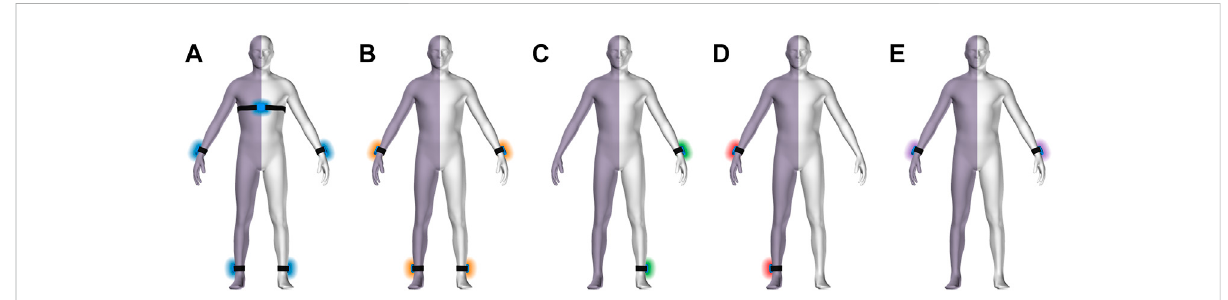
FIGURE 1 Body scheme with hemi-paretic side symbolized by violet shade. Sensor con fi gurations (A – D) with sensors locations: all sensors (A) , no chest sensor,bilateralwristandankle (B) ,unilateralwristandankleonthenon-affectedside (C) ,unilateralwristandankleontheaffectedside (D) ,andwrist sensors only (E)